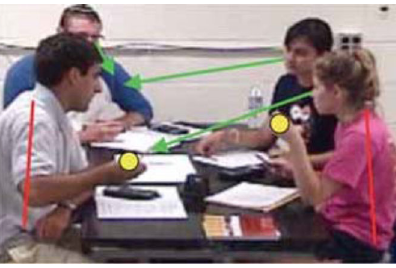
FIG. 4 (color online). Student behaviors oriented toward the strips.